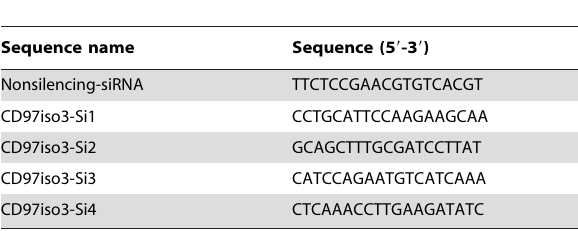
Table 1. RNAi candidate target sequences for CD97 isoform